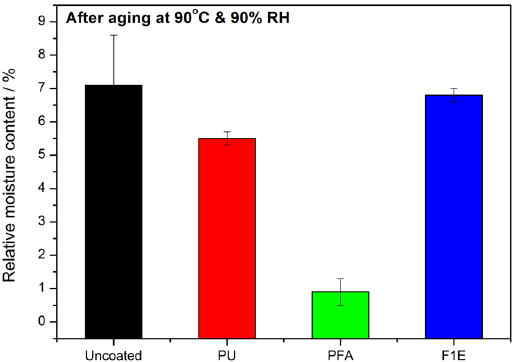
Figure 3. Relative moisture content of uncoated and coated flax/phenolic laminates after aging.